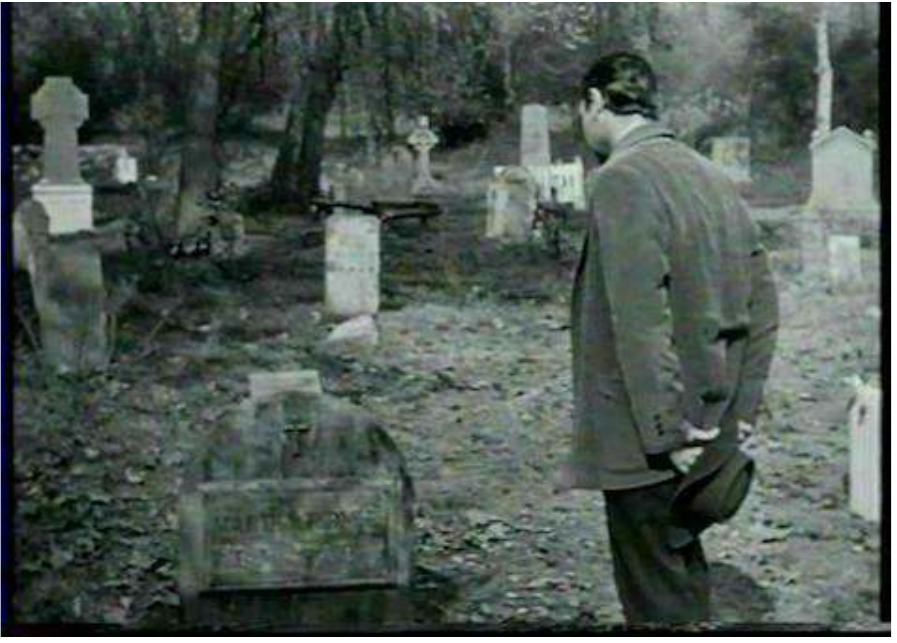
Figure 11: Wes discovering that Martha is dead in Colorado